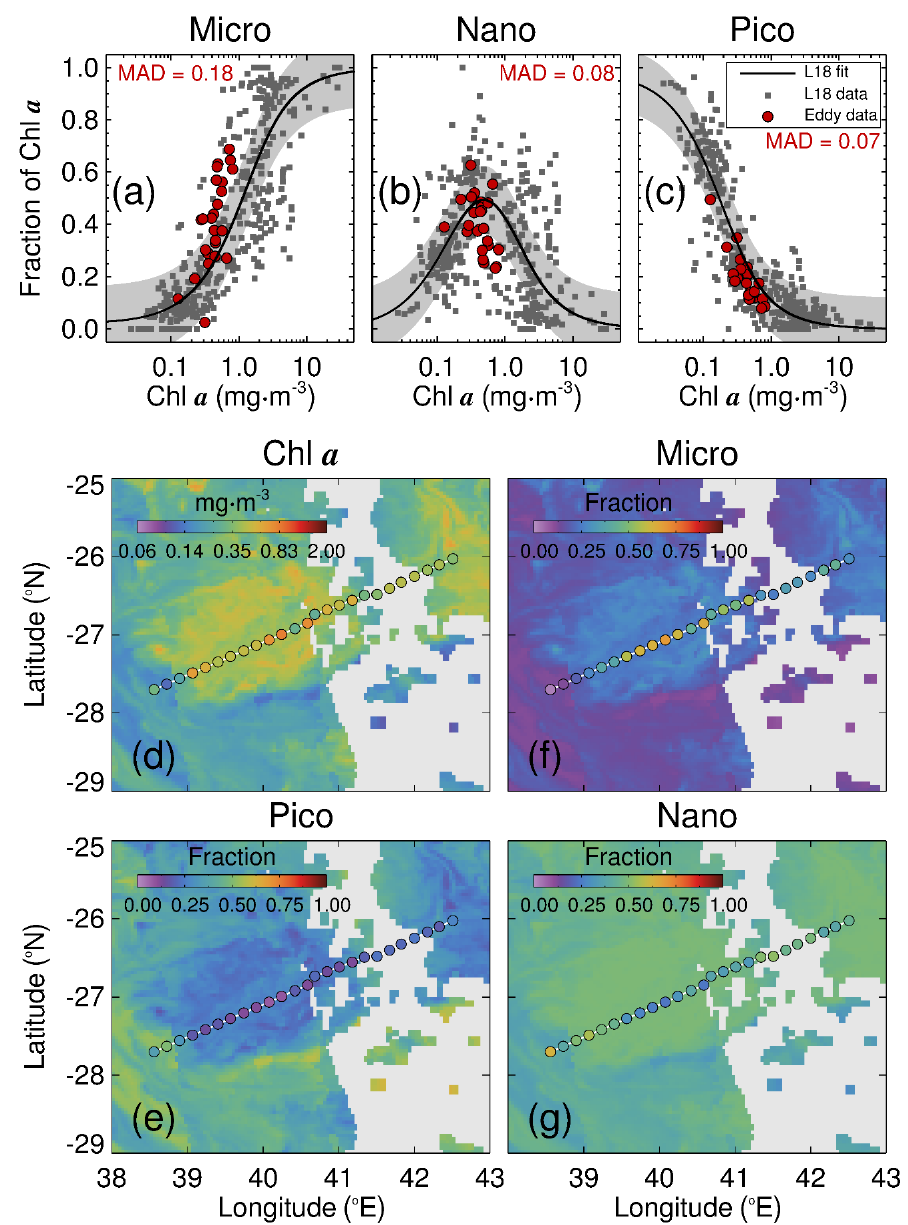
Figure 2. Verification of the use of the three-component model for studying phytoplankton size structure within the MB eddy. ( a – c ) show the fractions of micro-, nano-, and picophytoplankton, respectively, as a function of chlorophyll a for in situ measurements collected during the passage of the MB eddy with the three-component model overlain. For comparison, the data from the Lamont et al. [19] (L18) study is also shown, and the grey shading represents uncertainty in the fractions based on the validation in the L18 study (see their Figure 3). MAD is the median absolute difference between the model and the in situ size fractions from the MB eddy. ( d – g ) show the in situ chlorophyll a and size fractions overlain onto MODIS-Aqua estimates from 20 and 24 July 2013, merged (averaged) into a single image. The in situ samples are coloured on the same scale as the satellite images.